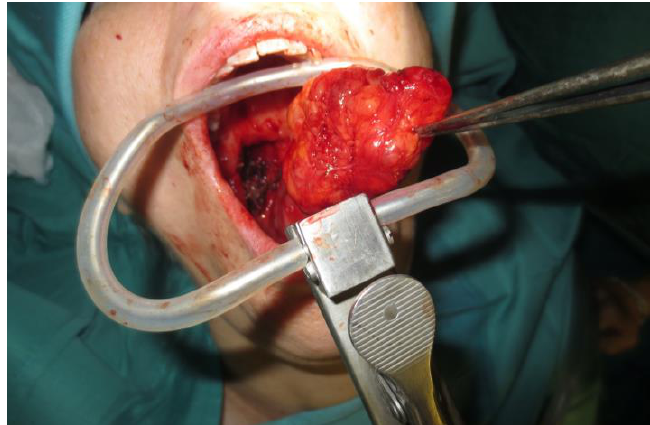
Figure 3. En bloc removal of the PPS tumour.